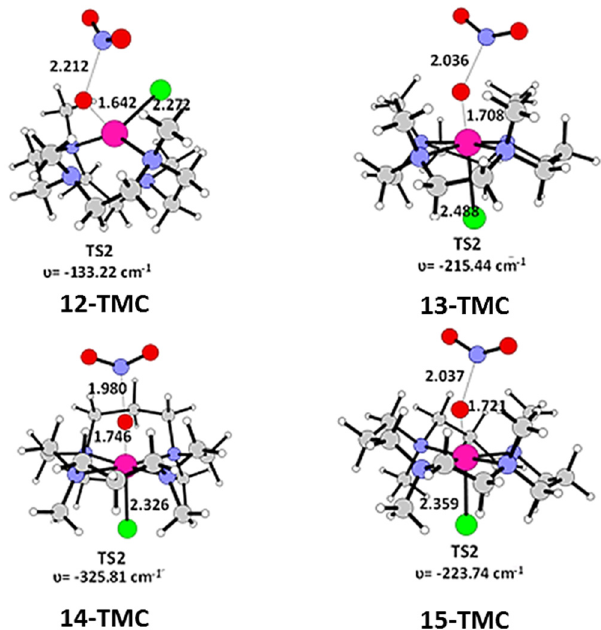
Figure 4. Optimized structures of TS2 species for all the investigated ligands along with the main geometrical parameters and imaginary frequency values. Selected bond lengths are in Å. Oxygen (red), chlorine (green), carbon (silver), nitrogen (azure), chromium (hot pink).